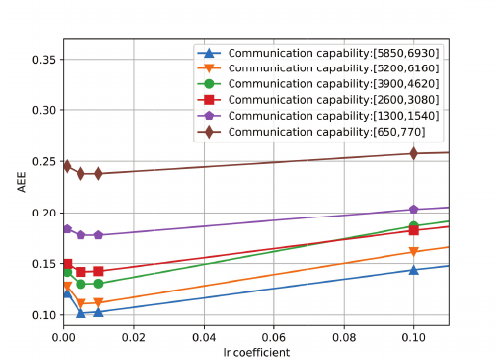
Figure 8. The AEE of the proposed algorithm under different learning rates.